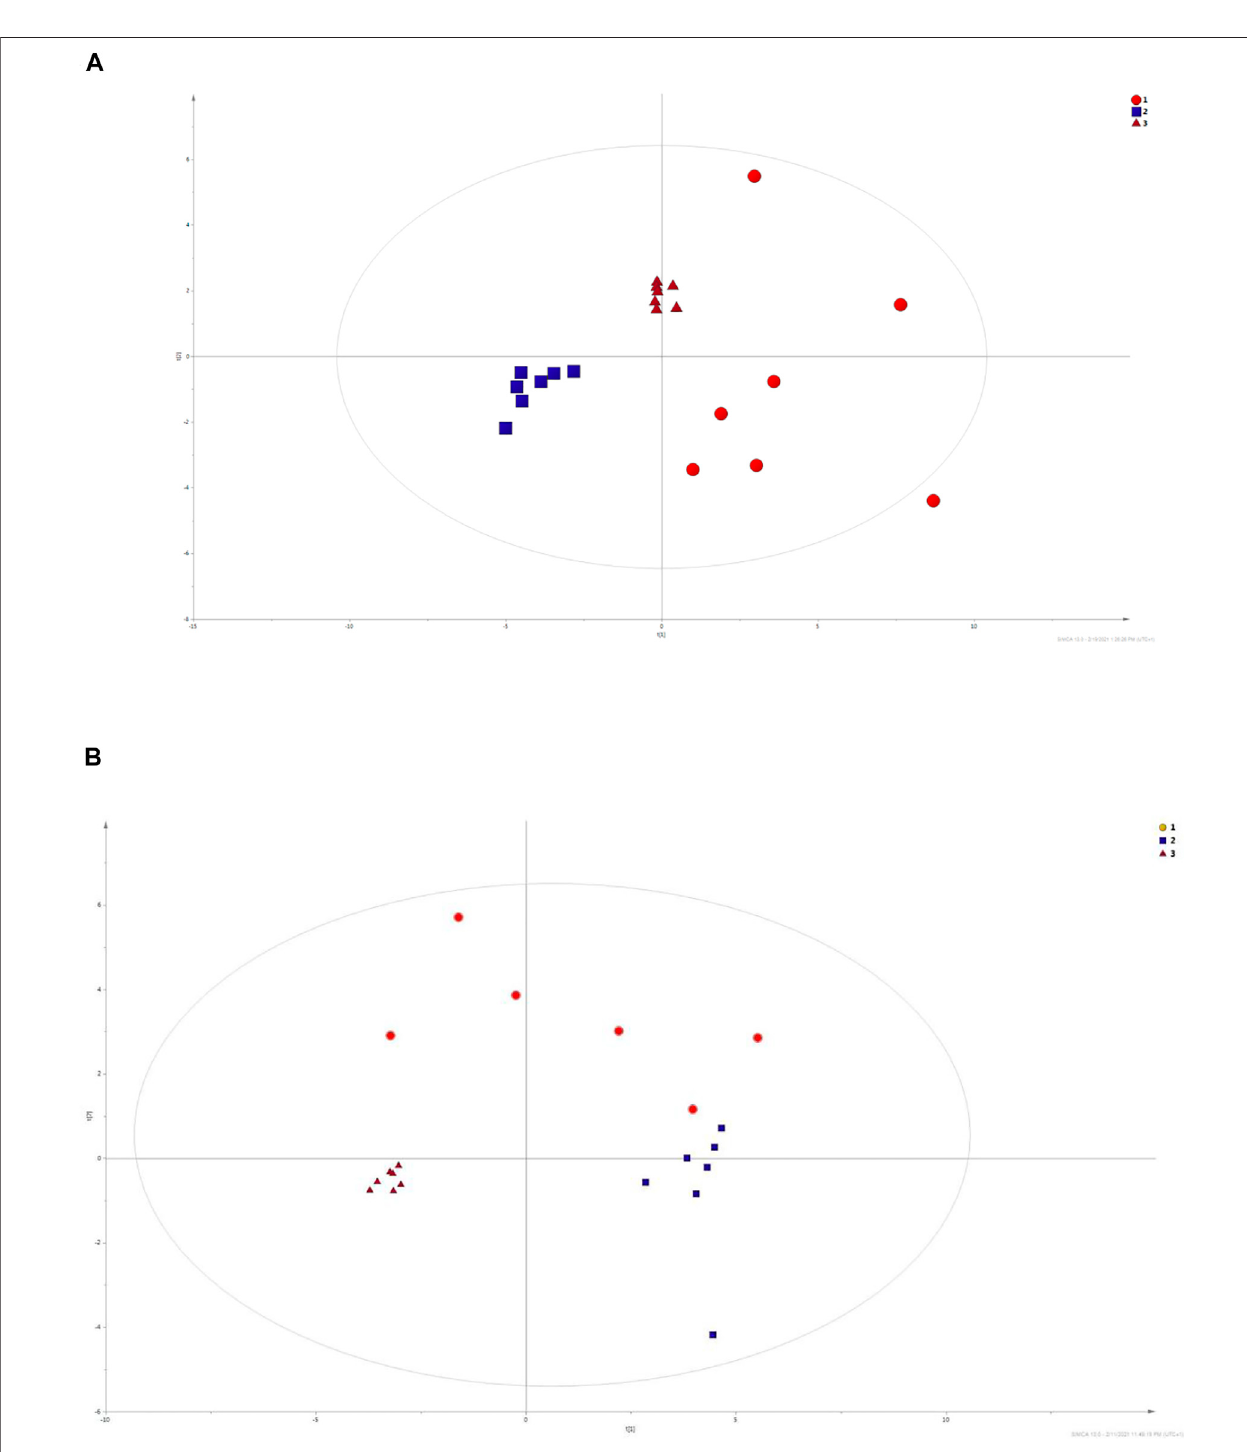
FIGURE 6 | PCA models built on data obtained with LC-ESI-TOF/MS in positive mode and GC-EI-QqQ/MS technique. The calculated R 2 factors were R 2 = 0.725 and R 2 = 0.736 for LC-MS in positive ionization mode and GC – MS, respectively. Ejaculate samples are assigned by red circles (1). Blue squares (2) correspond to urine samples, while serum samples (3) are marked with red